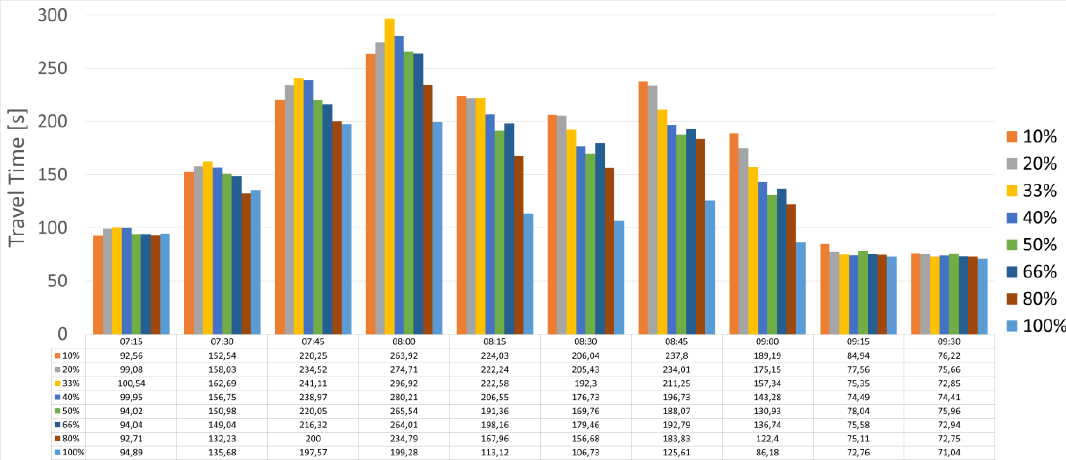
Figure 13. Travel time from Section 1 to Section 7 .